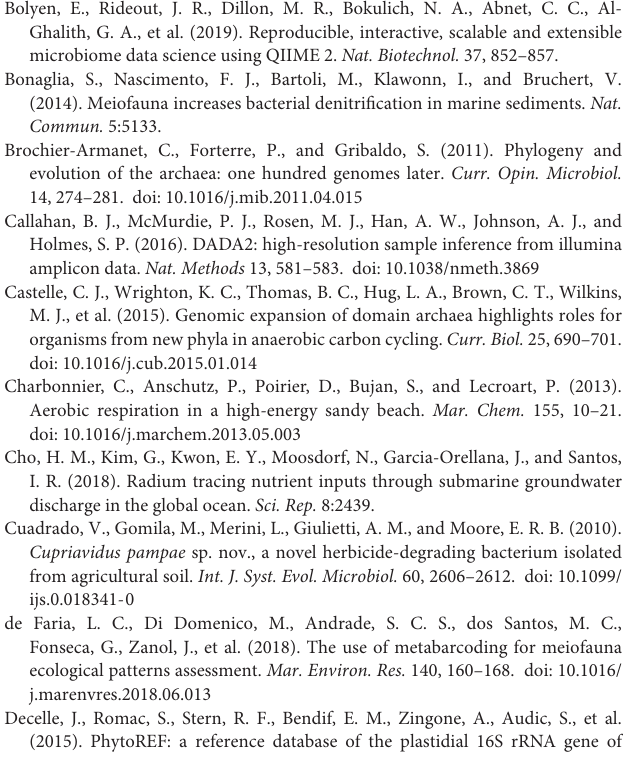
Supplementary Figure 1 | Location of the sampling site at Spiekeroog beach, modified after Ahrens et al. (2020) and Degenhardt et al. (2020). Displayed is a cross-section through the beach, including hydrological flow paths and beach morphology. The squares mark the sampling sites across the intertidal area. MHWL, mean high water line; MSL, mean sea-level; MLWL, mean low water